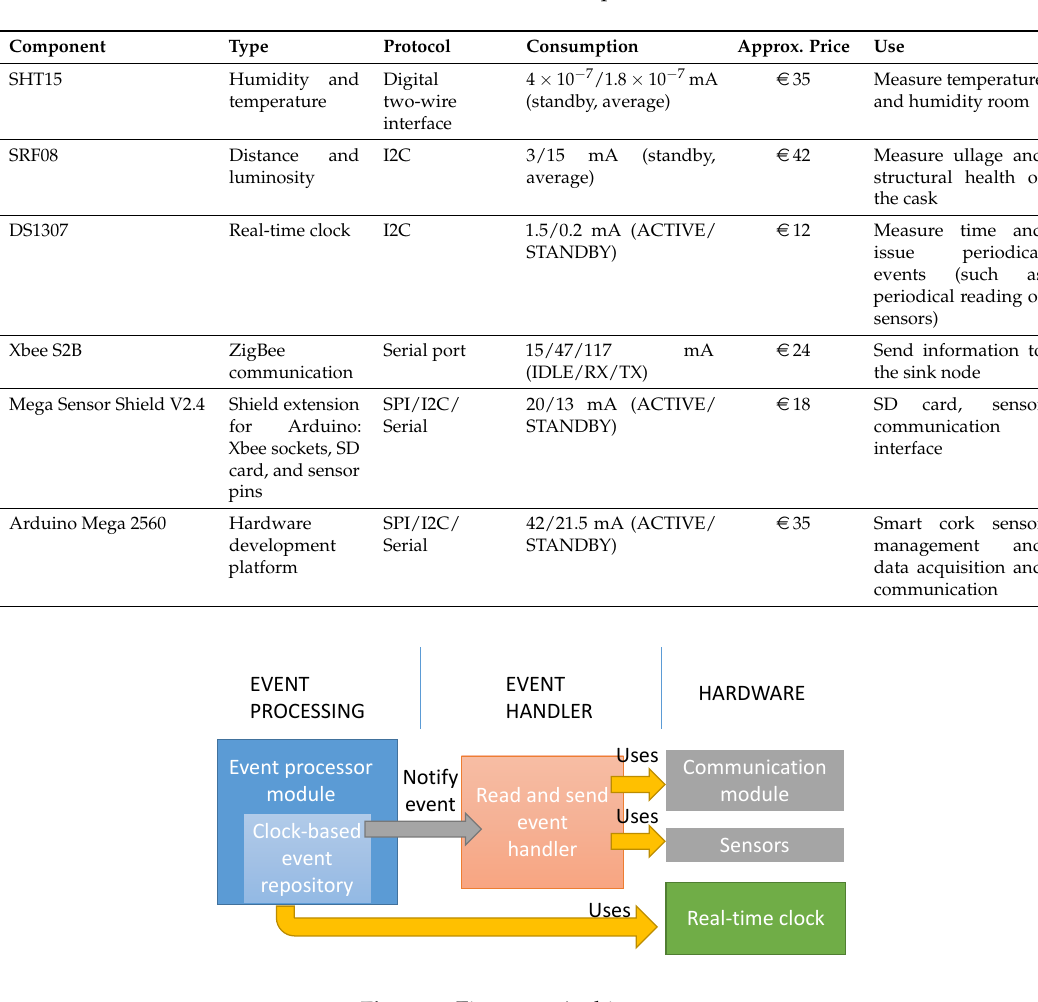
Table 1. Hardware components